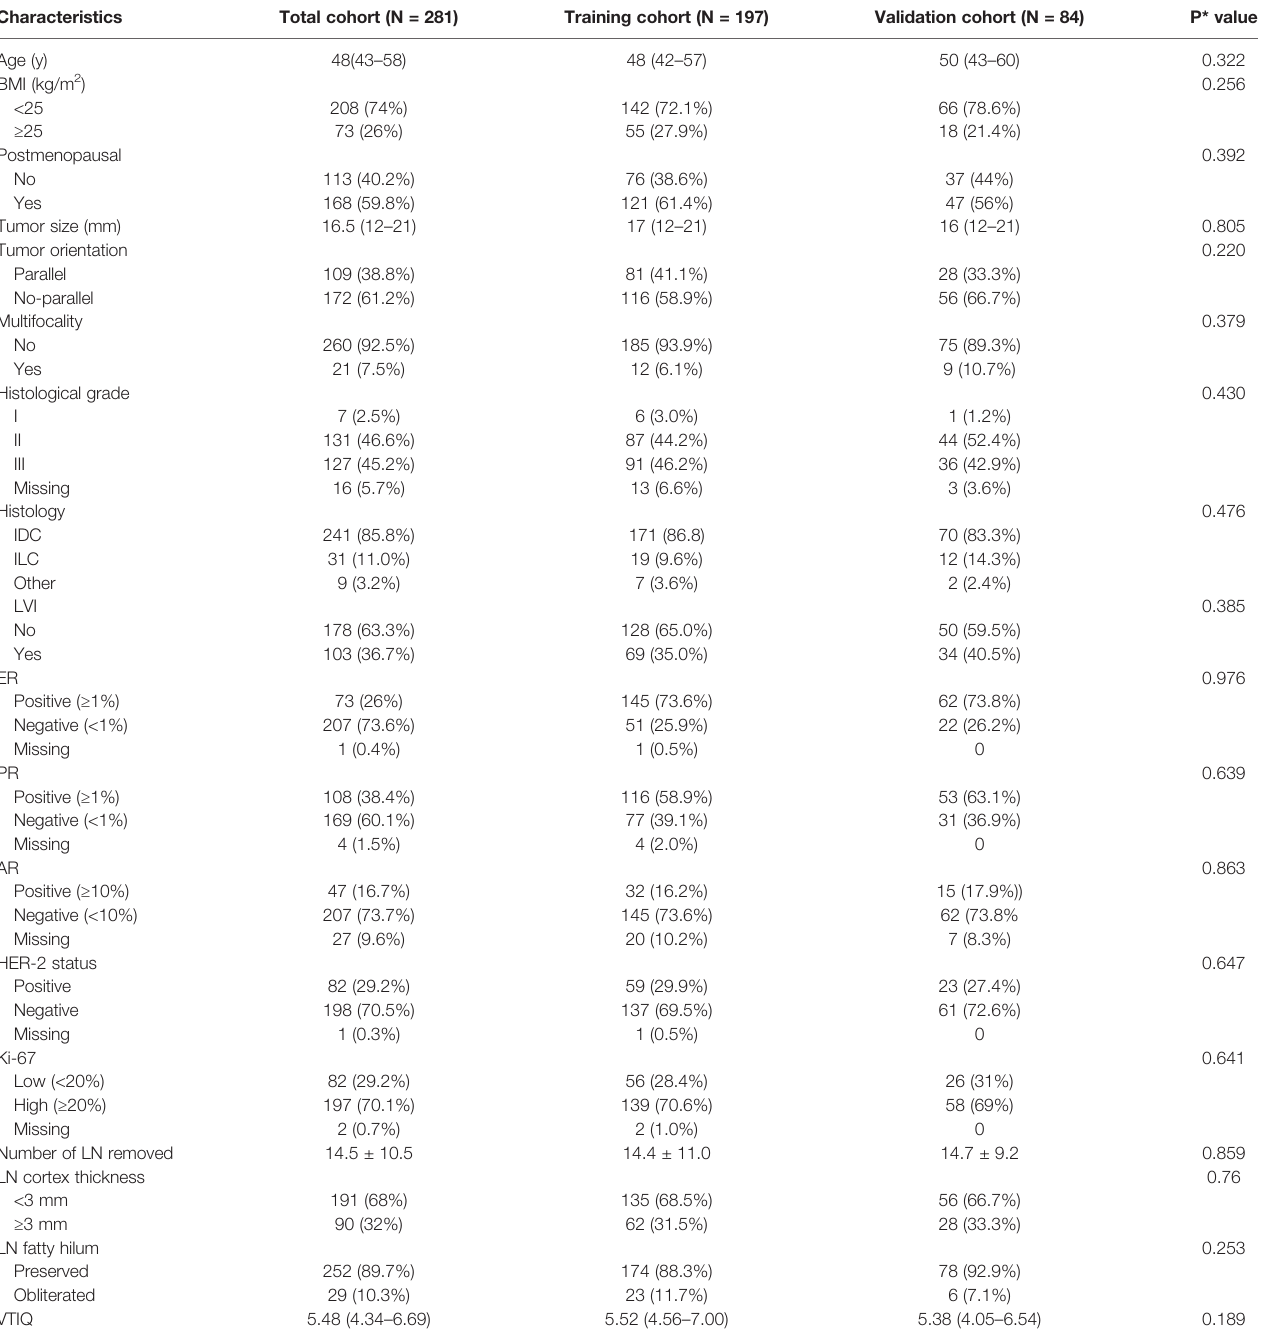
TABLE 1 | Characteristics of patients with breast cancer in the training and validation cohorts.